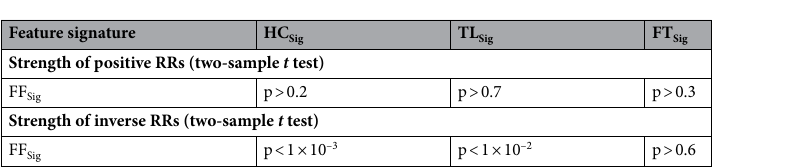
Figure 4. Venn diagram shows the distribution of unique genes that were associated with FF Sig , HC Sig , TL Sig , and FT